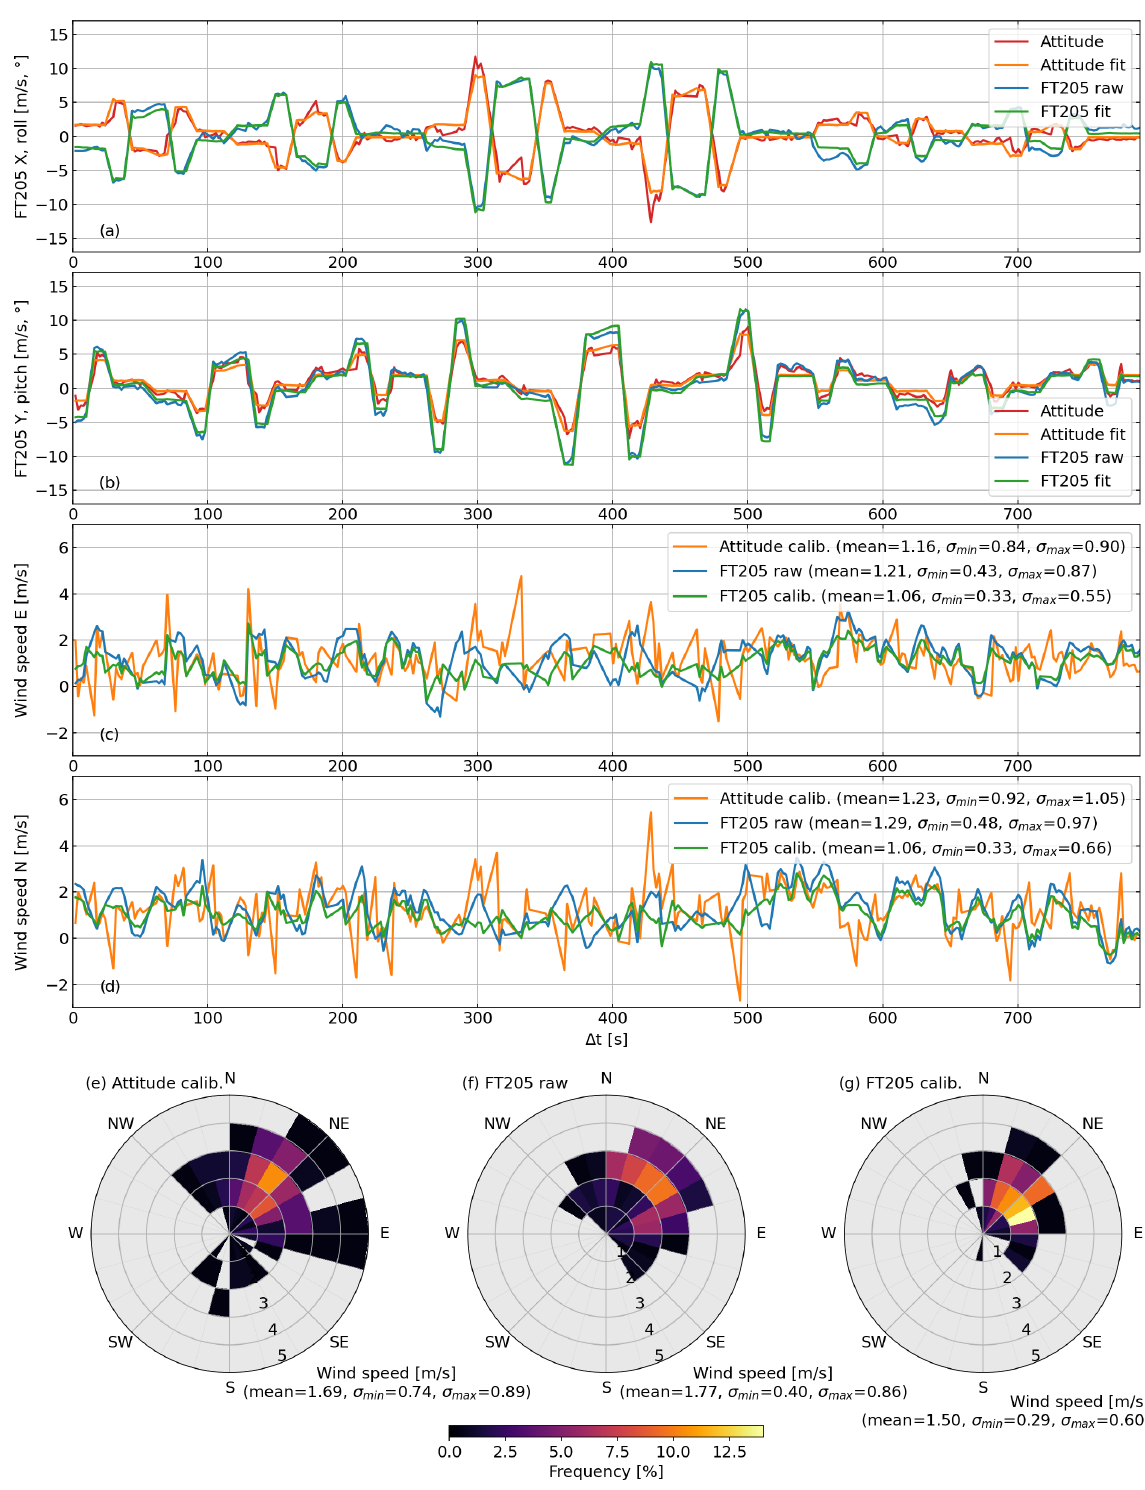
Figure 4. Results of the anemometer calibration experiment. (a) X component of the uncalibrated wind measurement and roll (blue and red, left side of Eq. 8) as well as corresponding fits (green and orange, right side of Eq. 8). (b) Y component of the uncalibrated wind measurement and pitch as well as corresponding fits. (c) Wind speed relative to ground in the east direction for the calibrated (green) and uncalibrated (blue) anemometer, as well as that computed from the attitude of the UAV (orange). (d) Wind speed relative to ground in the north direction. Histograms of wind speed and direction for the calibrated (g) and uncalibrated (f) anemometer, as well as that computed from attitude (e)